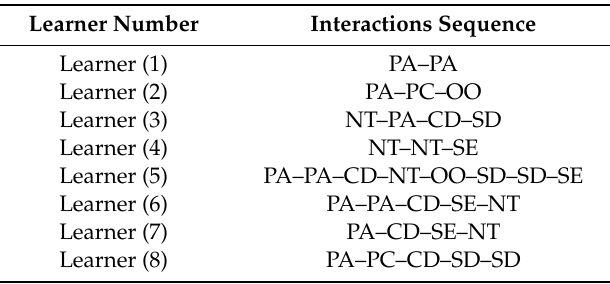
Table 12. A case study of FCS interactions sequence for Group 1.